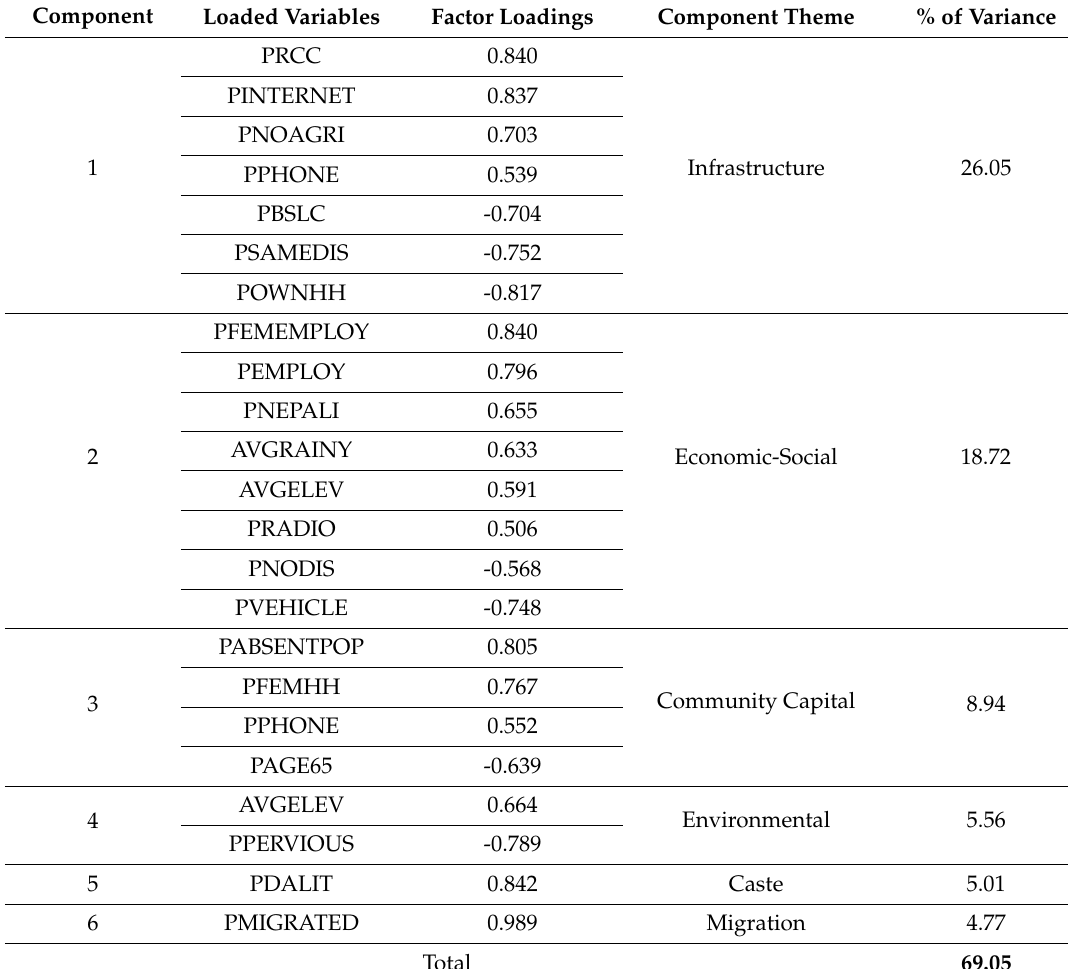
Table 4. Principal components, loaded variables, factor loadings, and percentage of